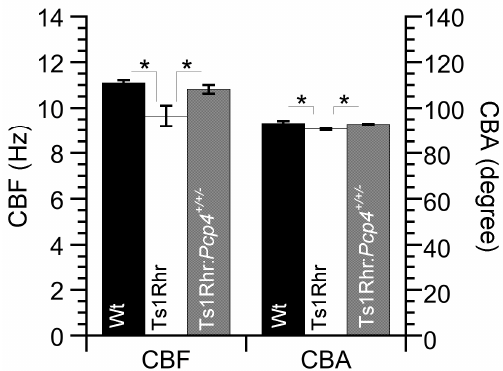
Figure 1. Basal ciliary beat frequency (CBF) and ciliary bend angle (CBA) of airway cilia in wild type (Wt), Ts1Rhr, and Ts1Rhr: Pcp4 +/+/- . The basal CBF and CBA of airway cilia are lower in Ts1Rhr than in